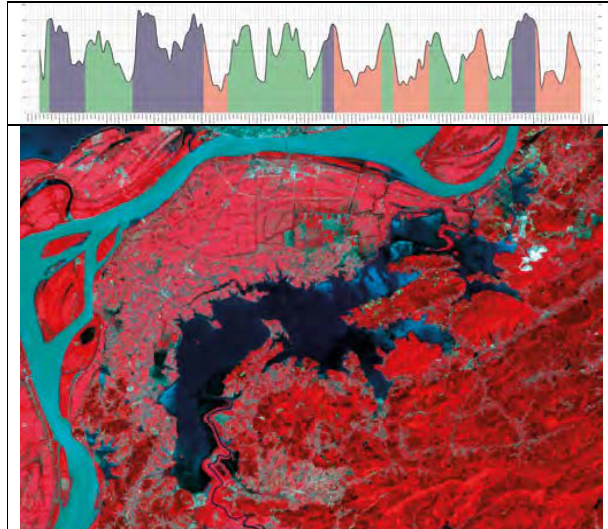
Figure 5. Poyang Lake water surface variations between 2000 and 2011 (top); Shengjin Lake (Anhui Pr) viewed by HJ-1 on the 3rd of May 2010 (42km) (bottom)